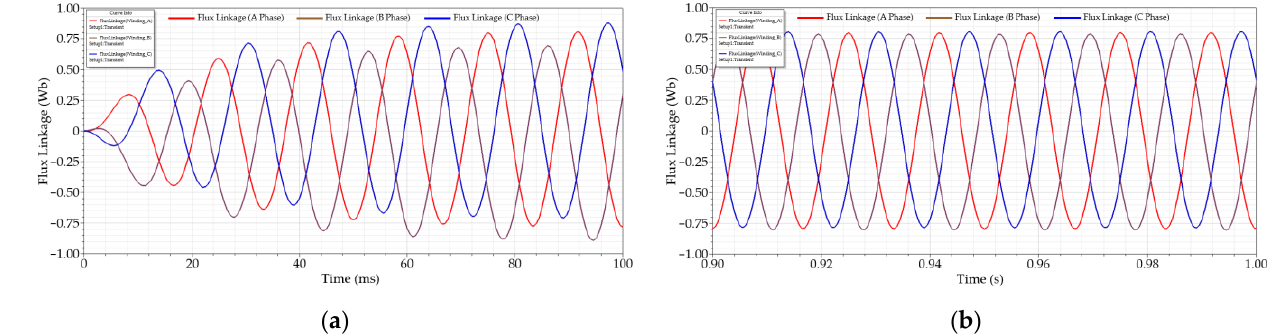
Figure 9. Simulation results of the winding flux linkage under the conventional equation. ( a ) 𝛽 = 50 ; ( b ) 𝛽 = 5.